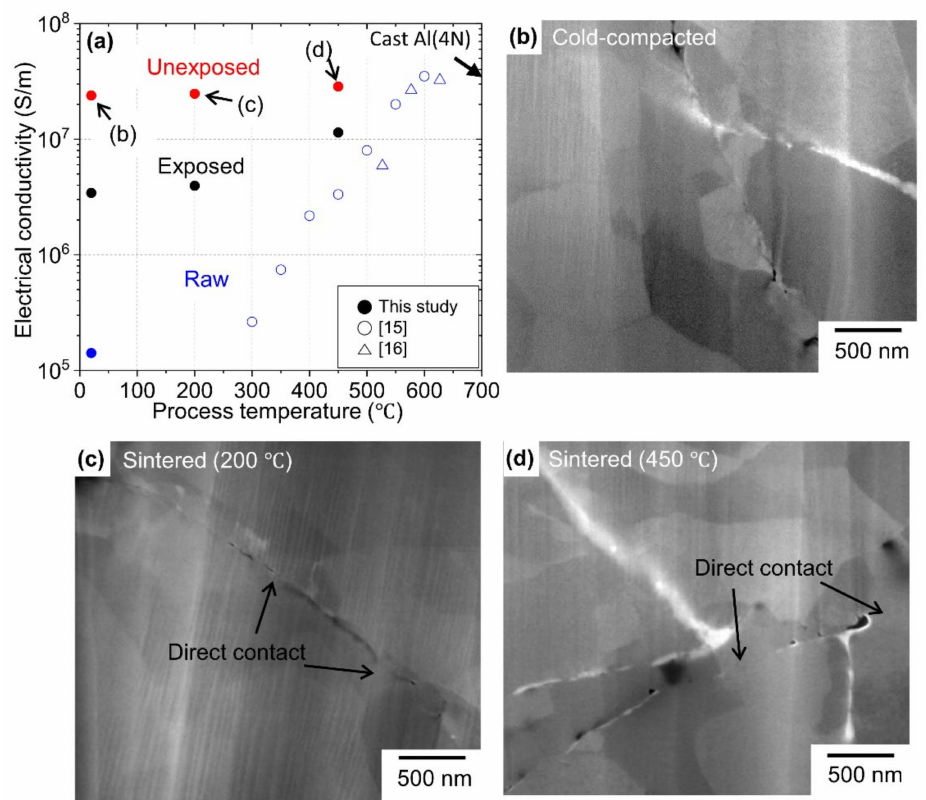
Figure 4. ( a ) Electrical conductivity as a function of process temperature for unexposed, exposed and raw Al compacts. FE-SEM images of unexposed compact Al that was ( b ) cold-compacted, ( c ) sintered at 200 ◦ C and ( d ) sintered at 450 ◦